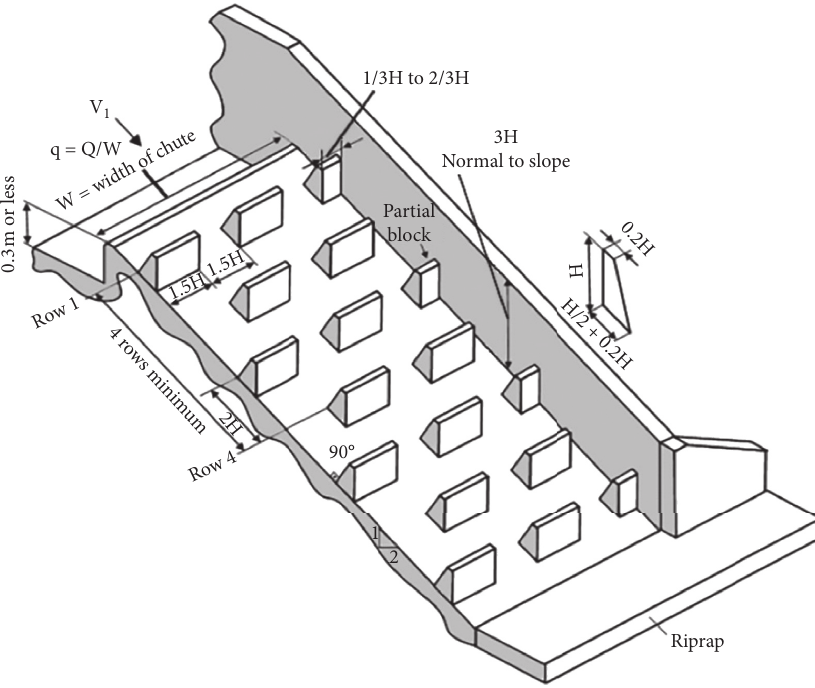
Figure 1: The components of a chute with trapezoidal baffle blocks